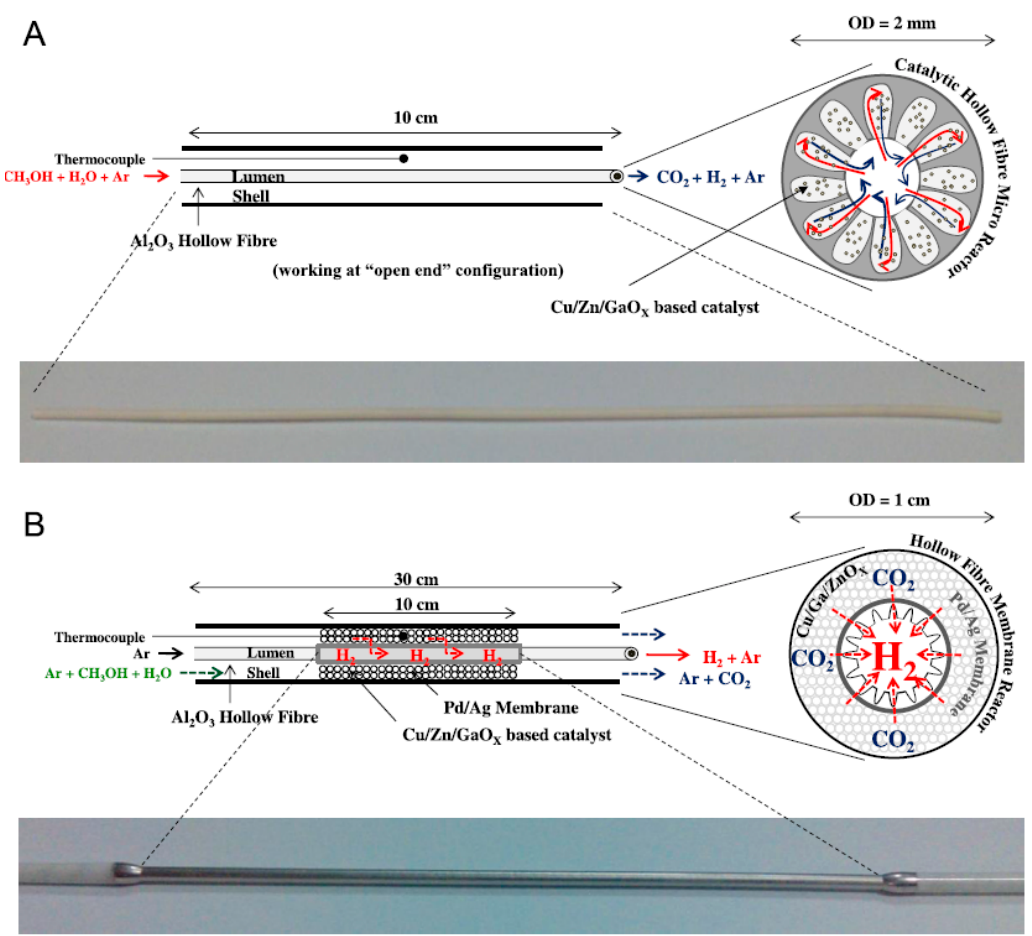
Figure 3. Representation of the catalytic CHFMR ( A ) and HFMR ( B ). Reprinted from [66] with permission from Elsevier.